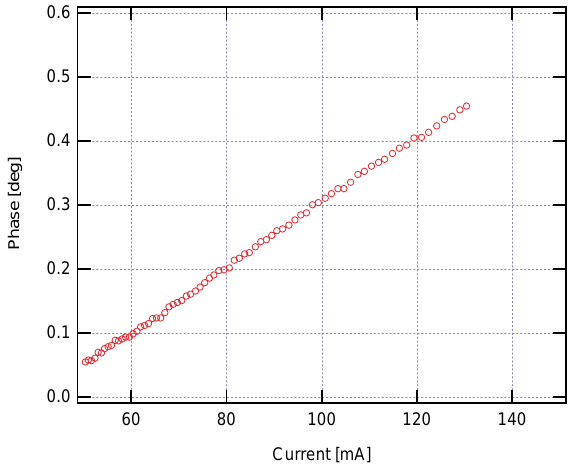
FIG. 6. (Color) Synchronous phase shift as a function of beam current at 1.1 GeV and 305 kV rf cavity gap voltage for a uniform filling. The slope gives the parasitic loss factor K pm (cid:1) 12 V (cid:1)